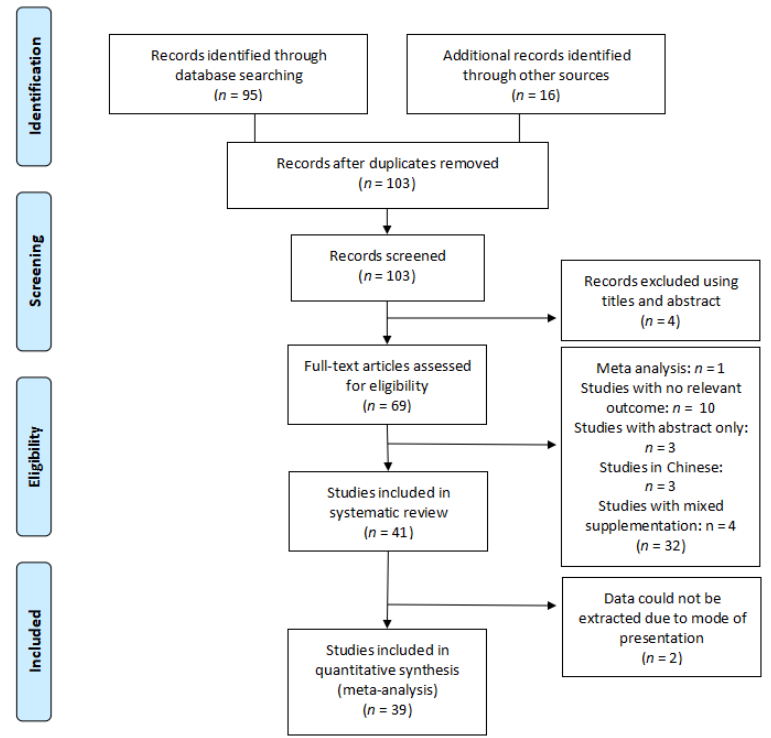
Figure 5. Flow diagram of the search strategy for glutamine.